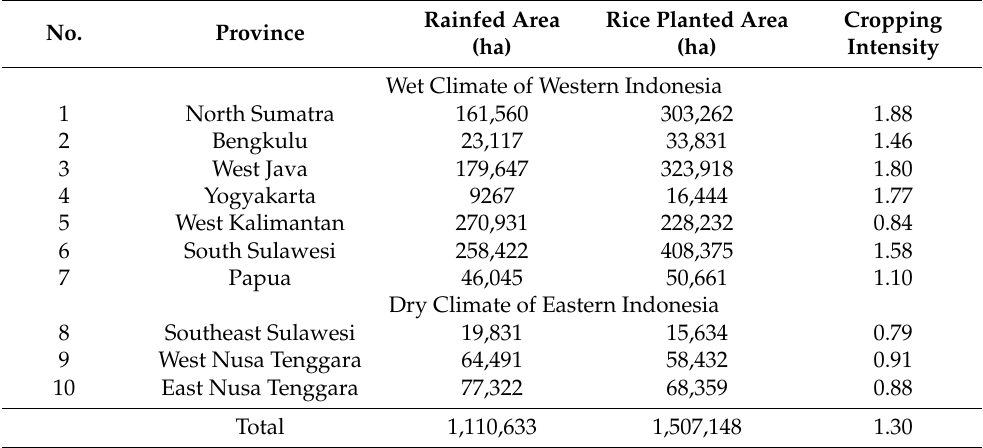
Table 3. Distribution of the existing rice cropping intensity (CI) in rainfed lowlands in ten provinces of Indonesia used as study areas,